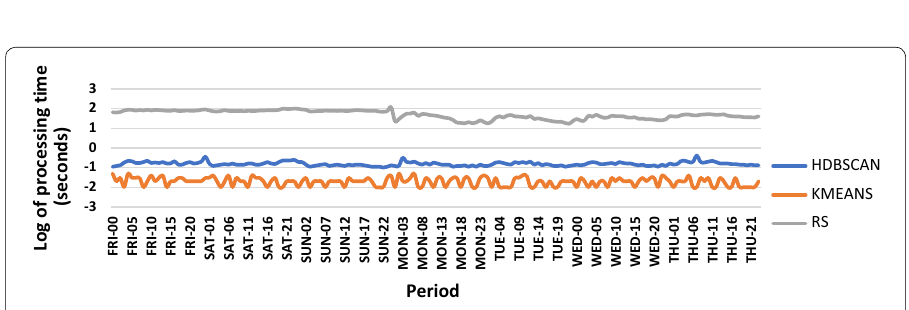
Fig. 10 Processing time for trips